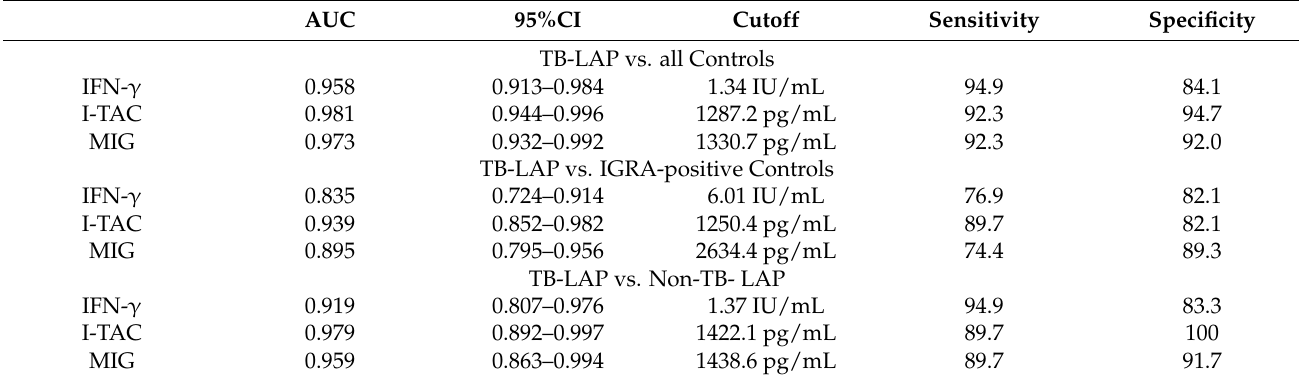
TB-LAP = tuberculous lymphadenitis; AUC = area under the curve; CI = confidence interval; IFN- γ = interferon- γ ; I-TAC = interferon- inducible T cell α chemoattractant; MIG = monokine induced by interferon- γ ; IGRA = interferon- γ release assay; non-TB-LAP = non- tuberculous